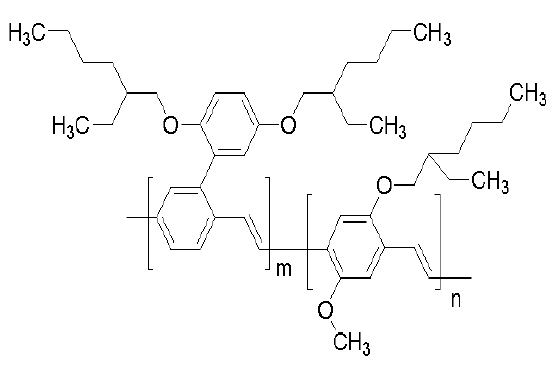
Figure 1. Molecular structures of the copolymer B-co-MP.